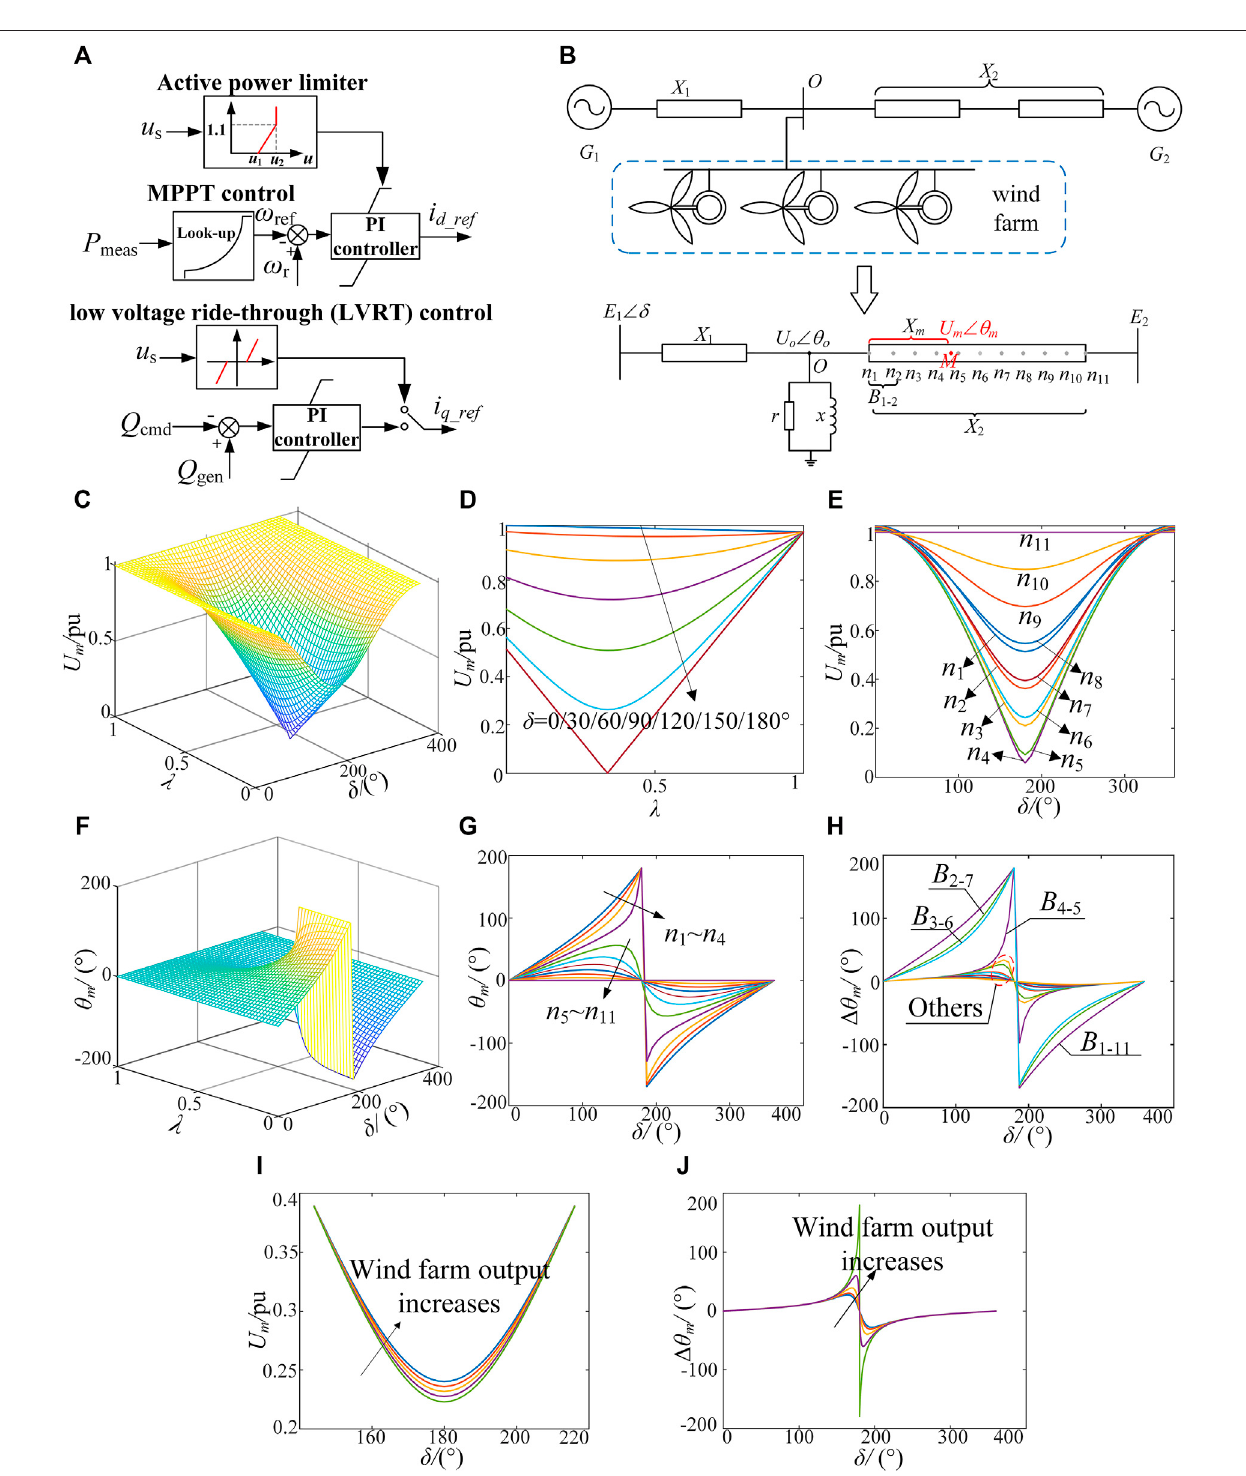
FIGURE 1 | Out-of-step oscillation characteristics of wind power system (A) is the control strategy of DFIG (B) is the equivalent two-machine system with DFIG integrated (C) isthedistributionlawof U m in δ - λ space (D) isthevariationlawbetween U m and λ (E) isthevariationlawbetween U m and δ (F) isthedistributionlawof θ m in δ - λ space (G) isthevariationlawof θ δ atdifferentposition (H) isthevariationlawbetween Δ θ δ ofdifferentbranches (I) isthevariationlawbetween U m with m and m atpoint n 4 and δ when wind farm output changes (J) is the variation law between Δ θ m of B 5-6 and δ when wind farm output changes.